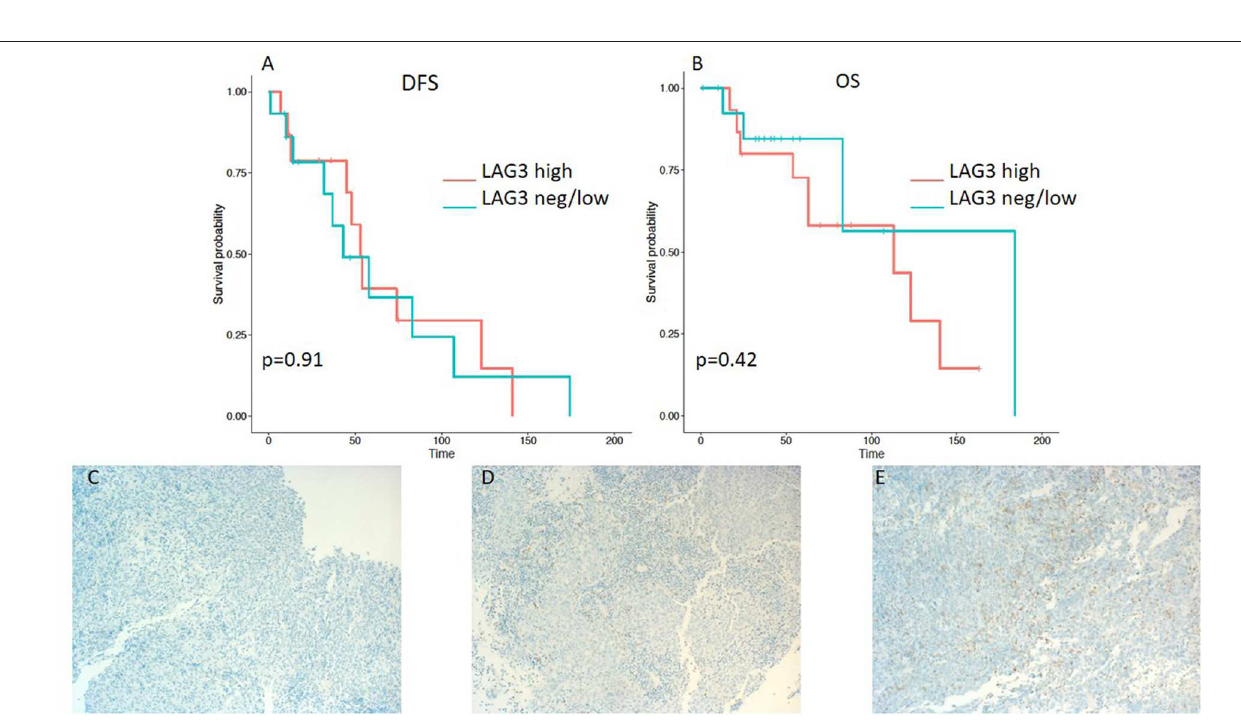
Frontiers in Oncology |